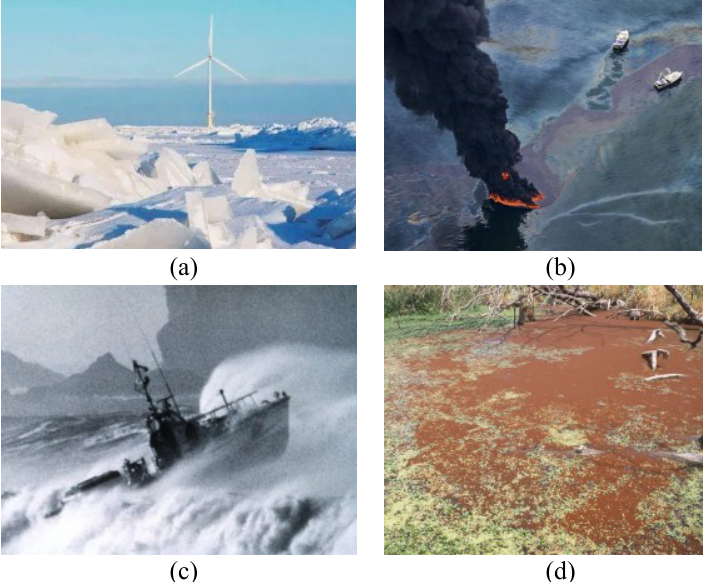
Figure 5. Natural disasters and environmental pollution: ( a ) sea ice; ( b ) oil spill; ( c ) storm surge; ( d ) red tide.